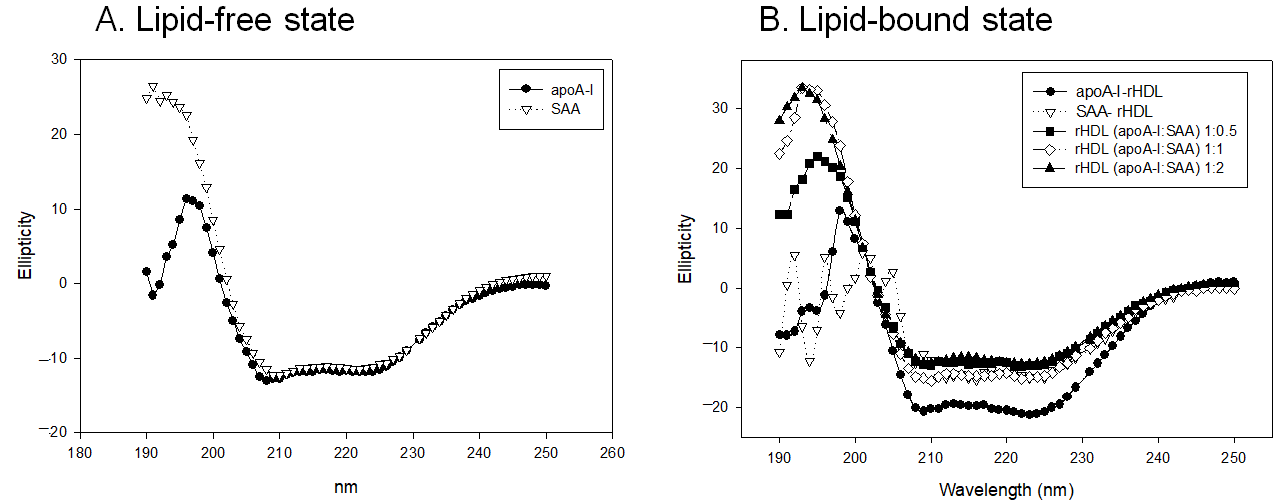
Figure 3. Circular dichroism spectra of apoA-I and serum amyloid A (SAA) in the lipid-free state ( A ) and lipid-bound state ( B ) as reconstituted high-density lipoproteins (rHDL) with different molar ratios of apoA-I:SAA.